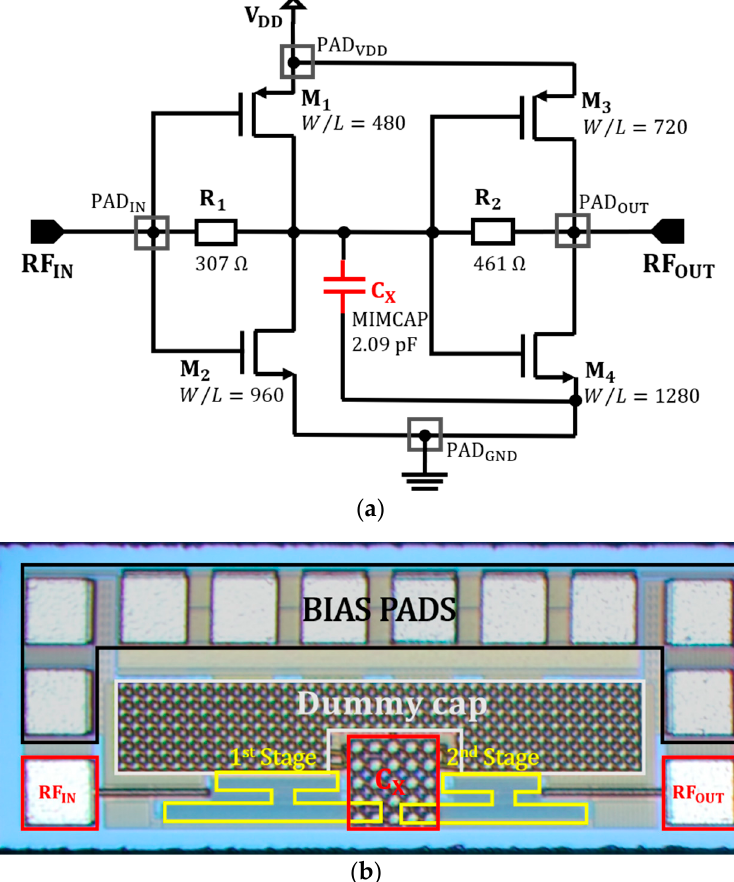
Figure 5. Proposed two-stage low-noise amplifier (LNA) in the radar sensor: ( a ) schematic of the LNA including external bond-wire inductances, and discrete and pad capacitances; ( b ) photograph of the fabricated LNA. Table 3. Simulation results of the proposed LNA at 915 MHz.